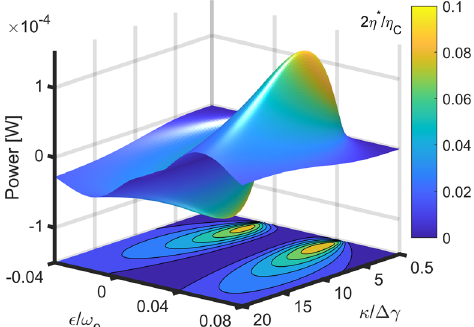
( z axis) and Fig. 4 Maximum power and ef fi ciency. Maximum power P (cid:5) out ef fi ciency η * normalized with respect to the maximum ef fi ciency η C /2 (color scale) at operational conditions corresponding to optimal terminal angular velocity Ω (cid:5) . These quantities are plotted as a function of the s coupling κ and resonance detuning ϵ for a fi xed temperature gradient. A perturbation on κ respects the pseudo-PT-symmetric nature of the unmodulated system, while a perturbation on ϵ violates this symmetry. In these extensive simulations, we have used the coupled mode theory modeling with parameters associated with the circuit setup: decay rates γ ≈ 3.6 × 10 − 3 , and γ ≈ 3.2 × 10 − 4 , resonance frequencies of each 1 2 resonator ω 1 ≈ 1 − κ , and ω 2 ≈ 0.94 − κ , all measured in units of the natural frequency ω 0 = 2 π × 1